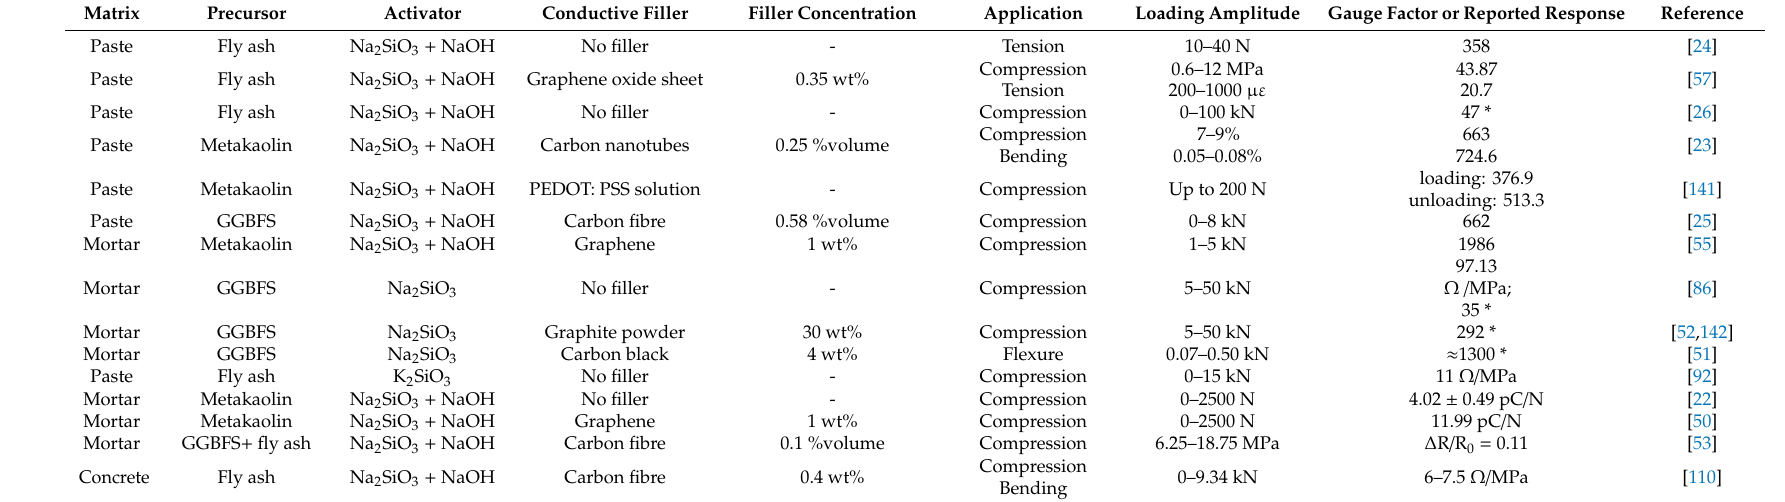
Table 3. Strain sensing performance of AAM. Notations-sodium silicate (Na 2 SiO 3 ), sodium hydroxide (NaOH), potassium silicate (K 2 SiO 3 ), potassium hydroxide